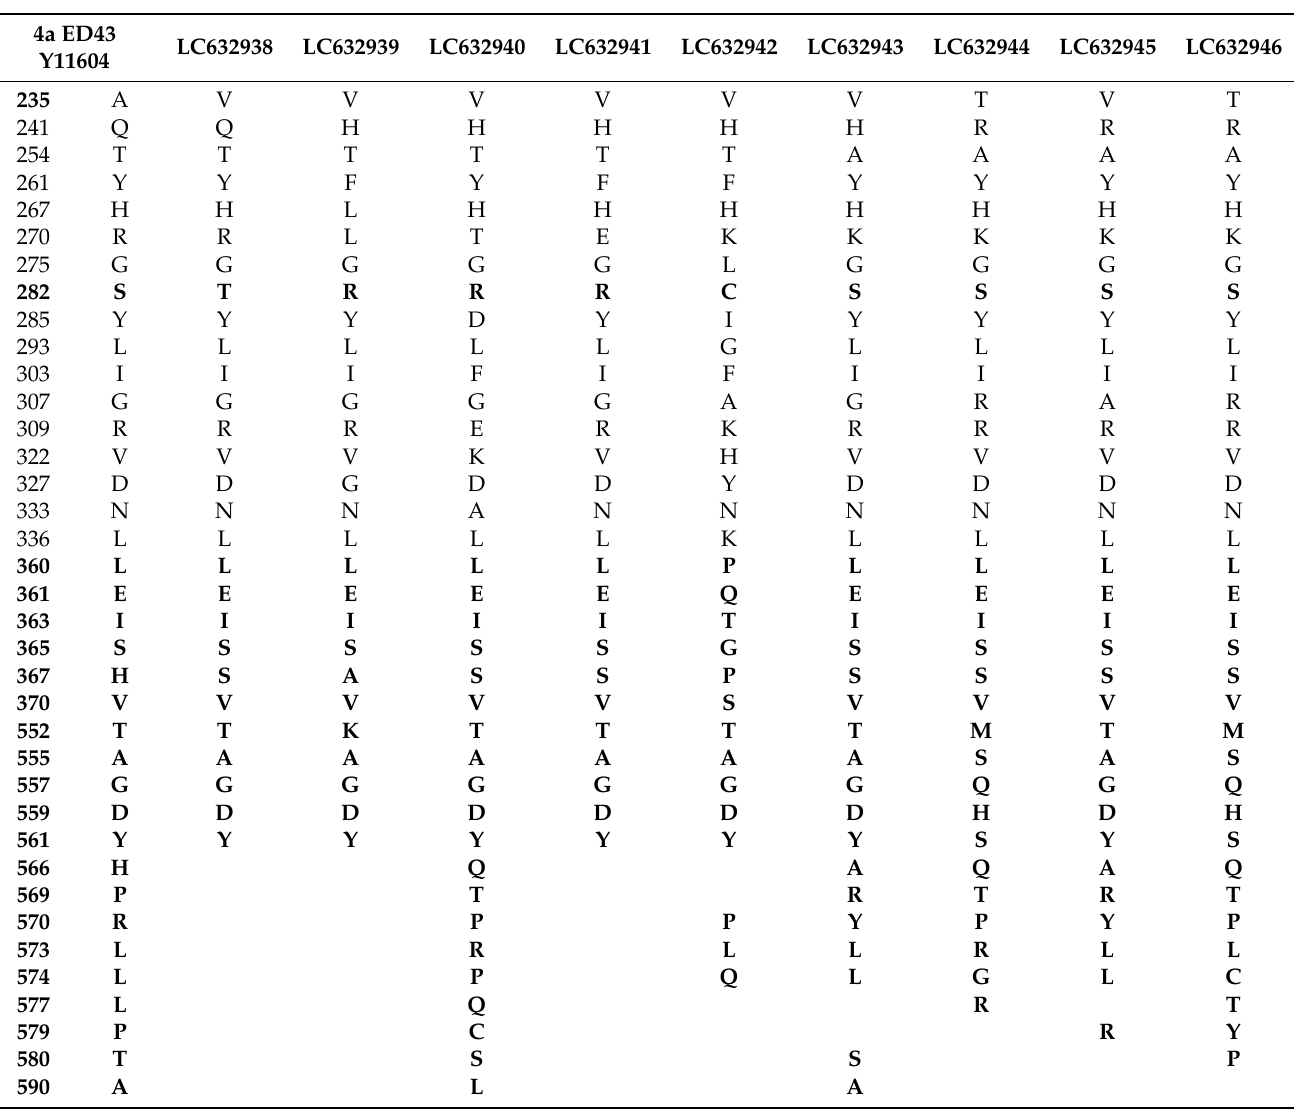
Table 3. Amino acid variance in the NS5B region of nine HCV